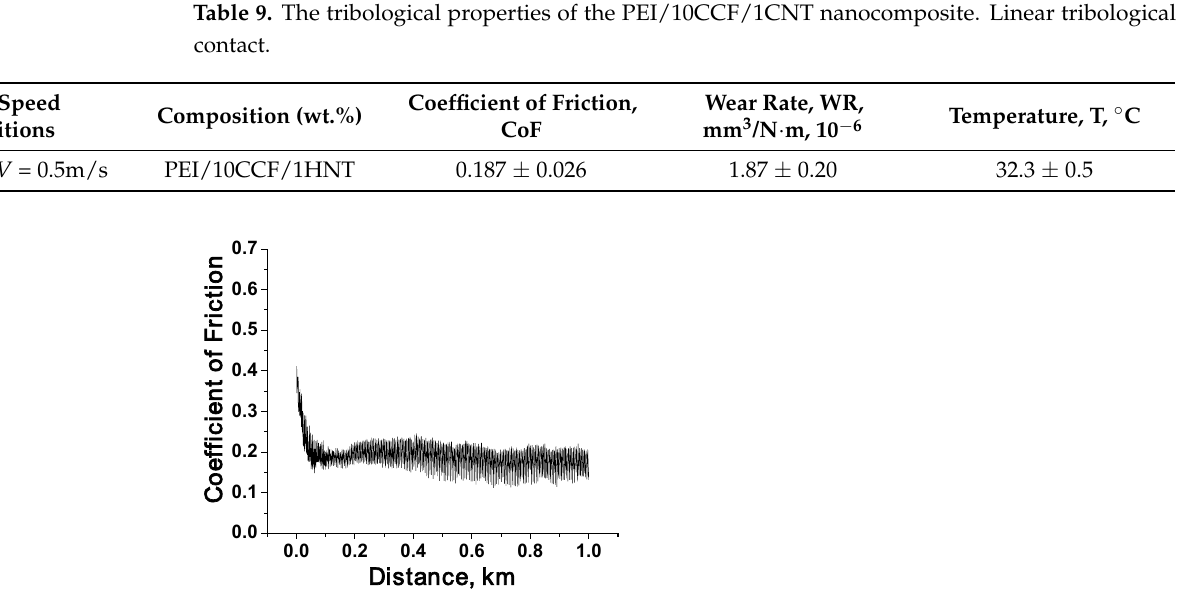
Figure 16. The time dependence in the CoF values for the PEI/10CCF/1CNT nanocomposite at P = 180 N, V = 0.5 m/s. Linear tribological contact.